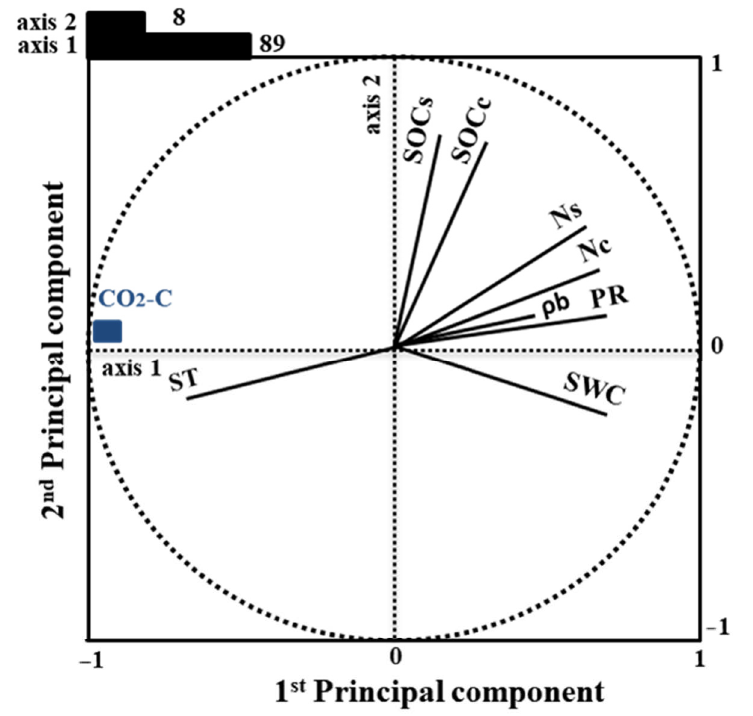
Figure 4. Principal components analysis (PCA) scatter diagrams for soil CO 2 -C from one side and selected soil factors (soil organic carbon content and stocks (SOCc; SOCs), nitrogen content and stocks (Nc; Ns), soil temperature (ST), soil water content (SWC), penetration resistance (PR) and soil bulk density ( ρ b) on the other side. N = 15.